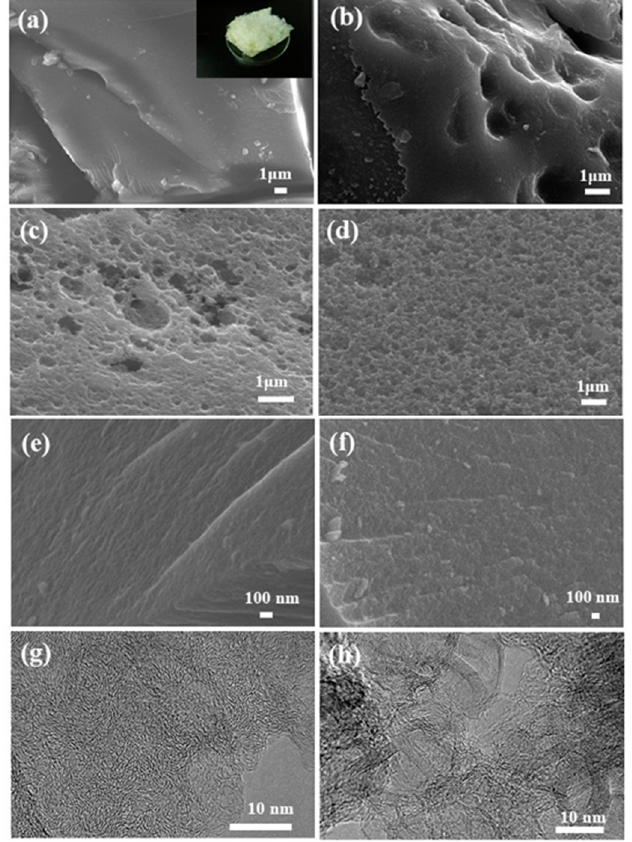
Figure 2. SEM images of the PUF/C ( a ), PUF/C-Ca(OH) 2 -973 ( b ), PUF/C-NaOH-973 ( c ), PUF/C-KOH-973 ( d ), PUF/C-CO 2 -1173 ( e ), PUF/C-CO 2 -1273 ( f ), and TEM images of PUF/C-CO 2 -1173 ( g ) and PUF/C-CO 2 -1273 ( h ). The inset in ( a ) is a photo showing the morphology of waste polyurethane foams.